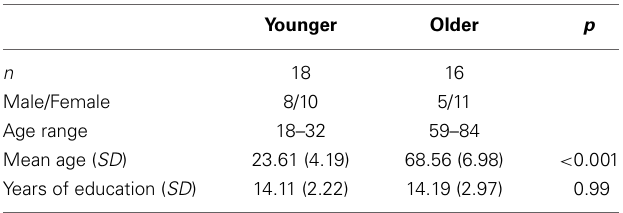
Table 1 | Summary of demographic characteristics for young and older